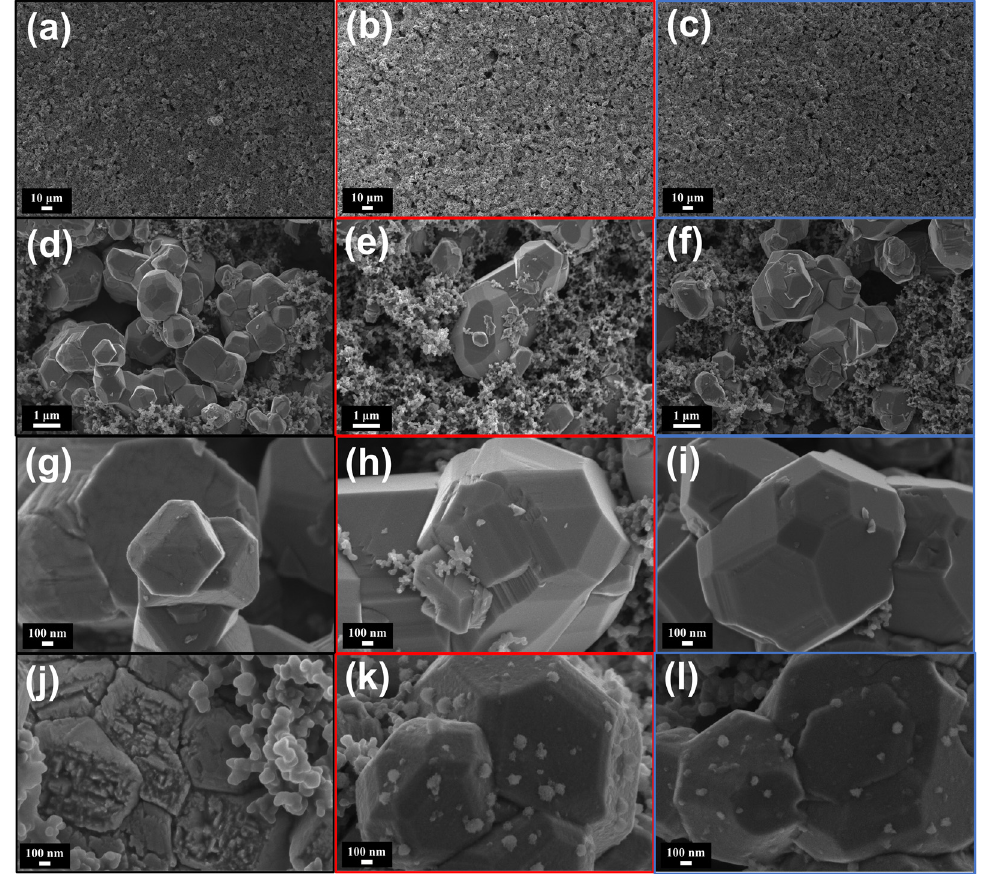
Figure 5. FE-SEM micrographs of pristine and aged cathode electrodes (for 1000 cycles) at differ- ent magnifications: ( a , d , g ) pristine LNMO-PVdF electrode; ( b , e , h ) pristine LNMO-CMC electrode; ( c , f , i ) pristine LNMO-TG electrode; ( j ) cycled LNMO-PVdF electrode; ( k ) cycled LNMO-CMC elec- trode; ( l ) cycled LNMO-TG electrode.